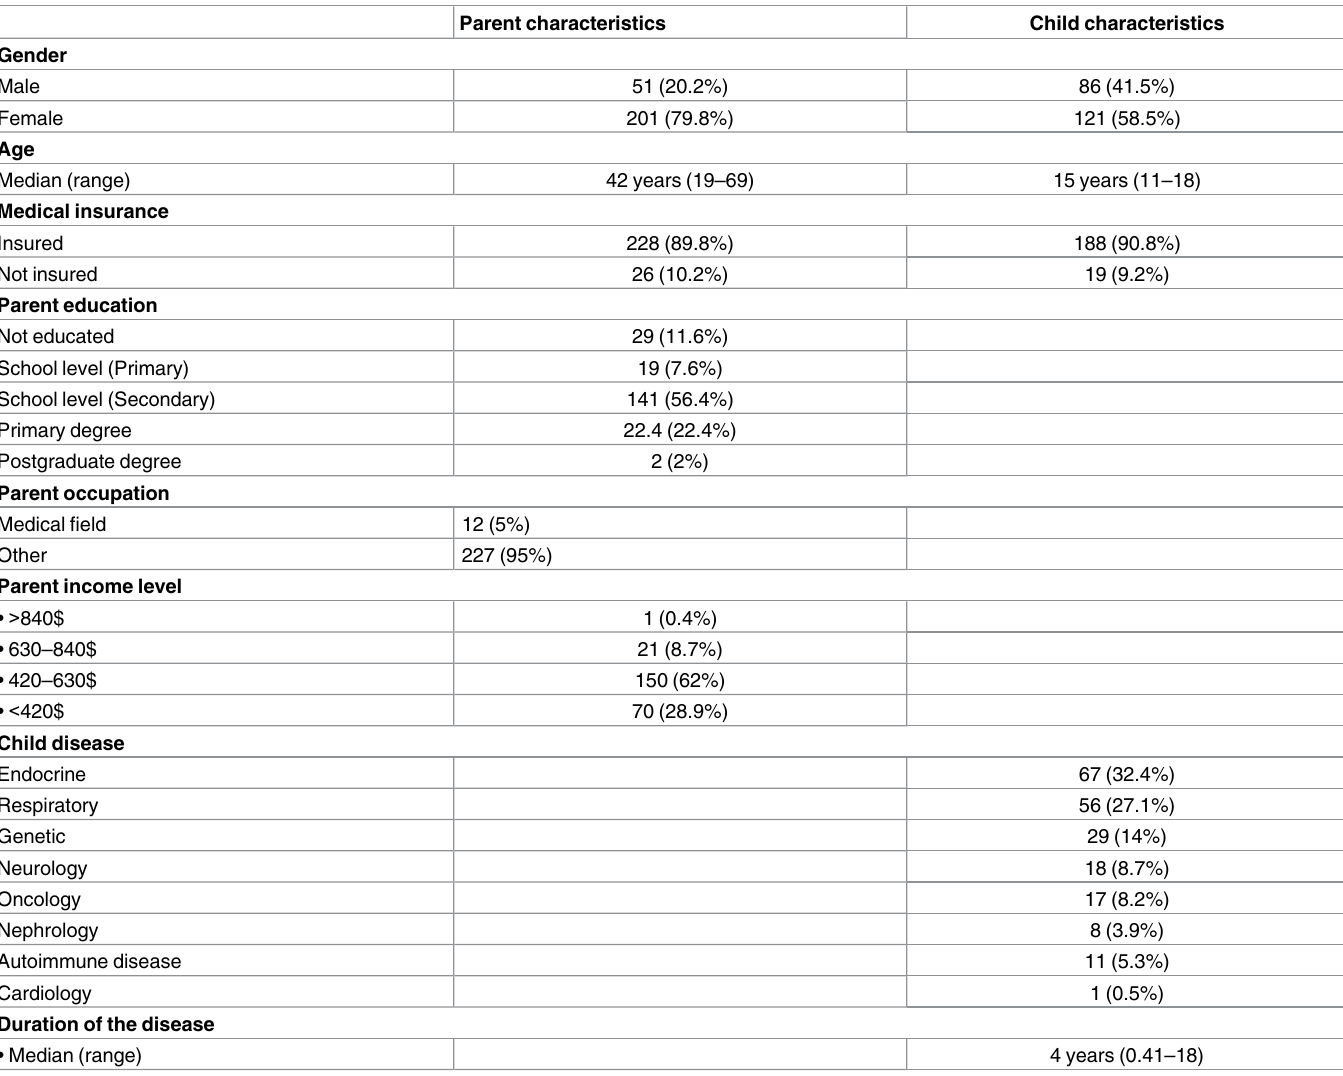
Table 1. Demographic characteristics of the